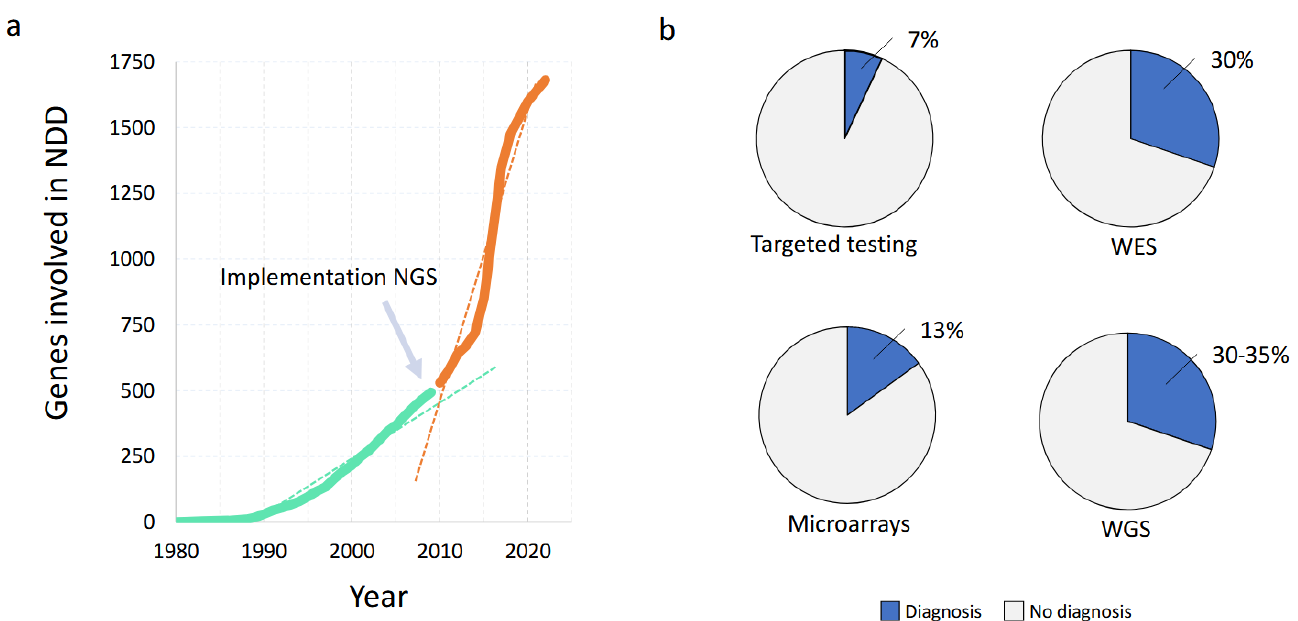
Figure 6. Schematic representation of the increase in genes associated with neurodevelopmental disorders and the respective diagnostic yields from assay used to find the underlying genetic cause. ( a ) The number of genes has significantly increased since the use of NGS-based assays (green line: pre-NGS; orange line: post-NGS, with dashed lines showing the trendline of the increase). ( b ) Diagnostic yields of the individual techniques when used as singular approach. A targeted strategy provides only a diagnosis in 7% of patients (phenotype-first), whereas the broader genotype-first approaches provide a diagnostic yield of up to ±35%.